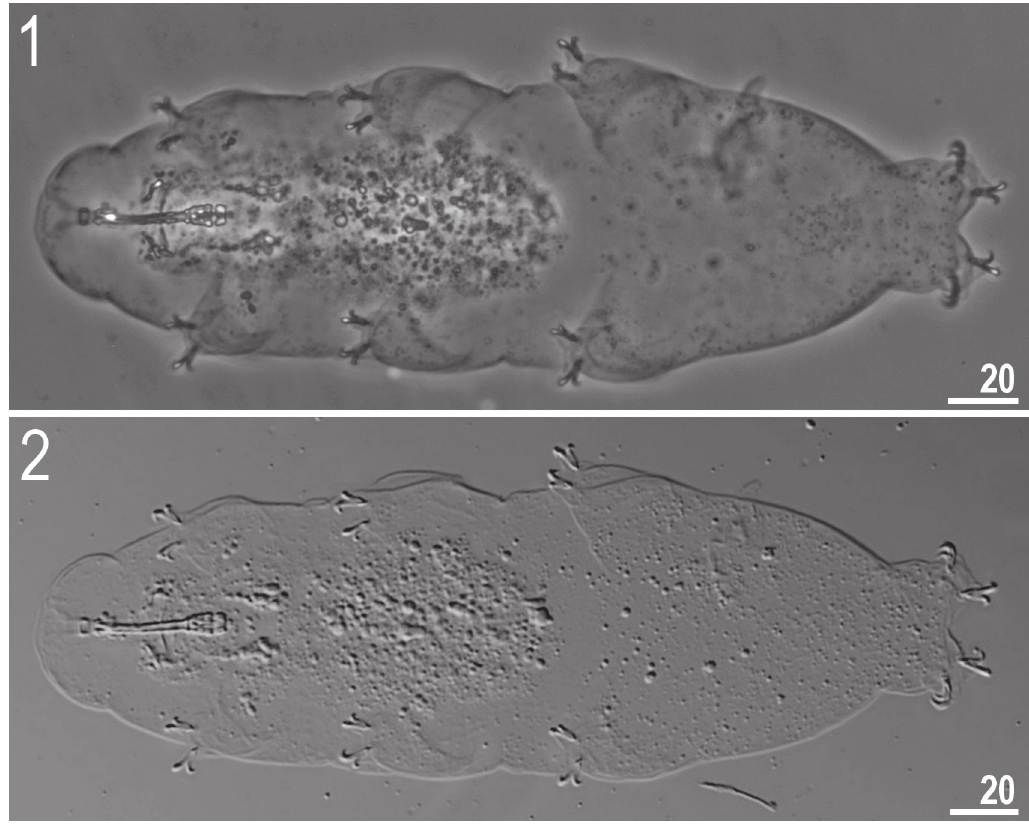
Figs 1–2. Macrobiotus polypiformis sp. nov., holotype, habitus, dorso-ventral projection. 1 . Seen in PCM. 2 . Seen in DIC. Scale bars in